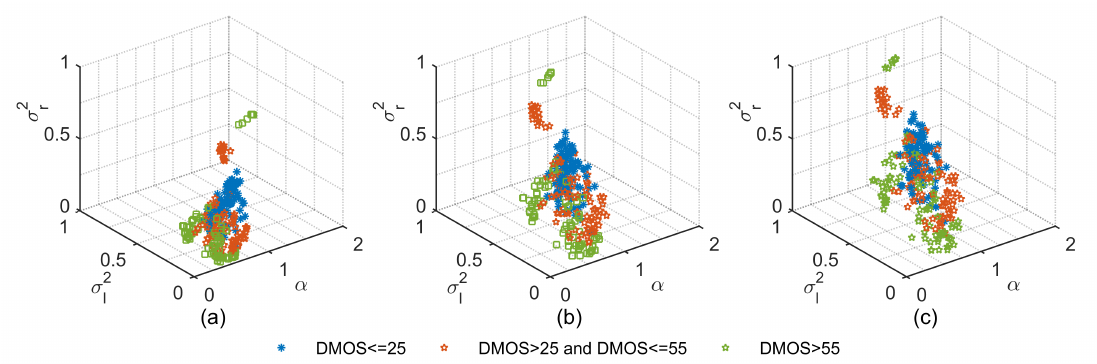
and σ 2 r in horizontal orientation of the l